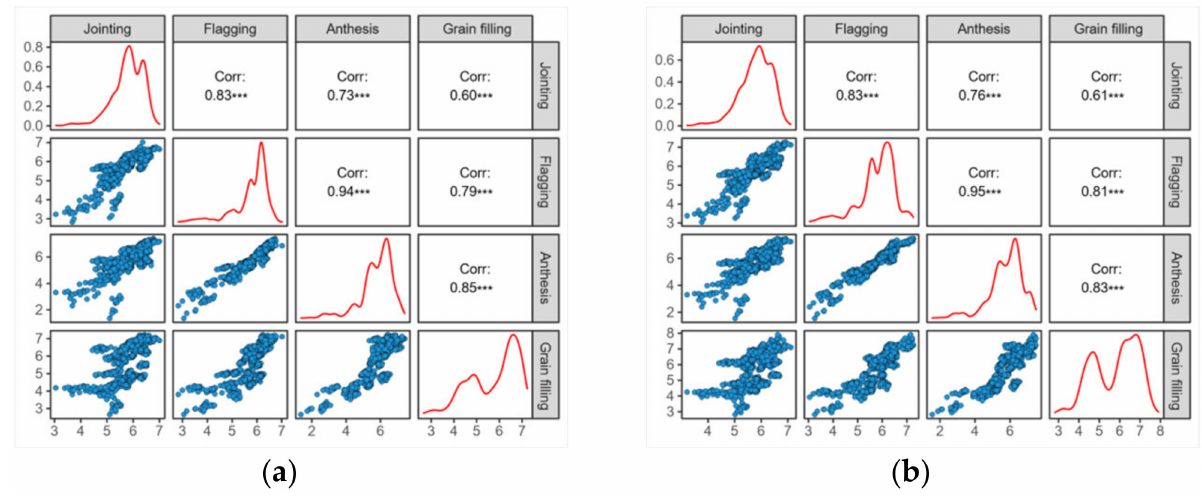
Figure A3. Regression plots, density curves and correlation coefficients for grain yield predictions generated by the four growth stages. In the four key growth stages. ( a ) Without LAI; ( b ) With LAI. Significant (***) at p <